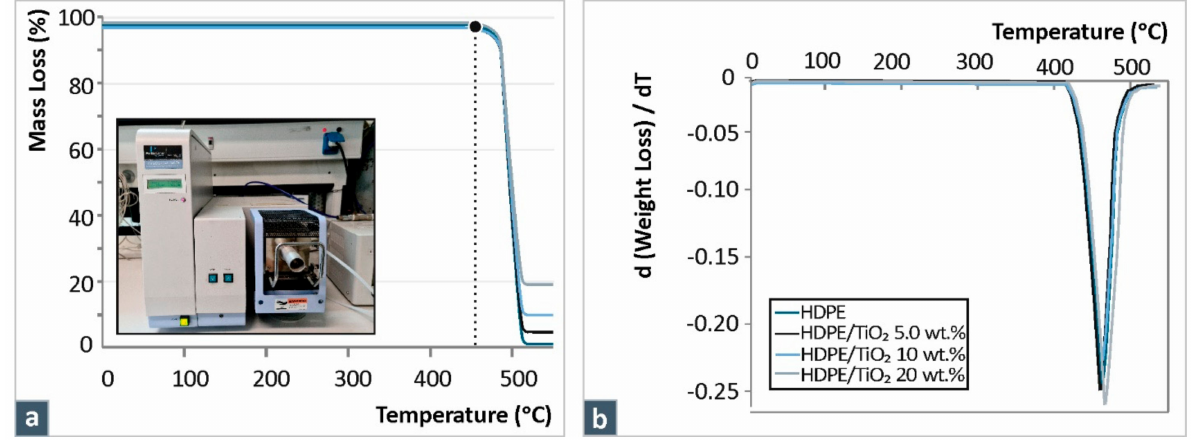
Figure 5. ( a ) TGA data for HDPE with TiO 2 filler at 0, 5, 10, and 20 wt.%; and ( b ) weight loss